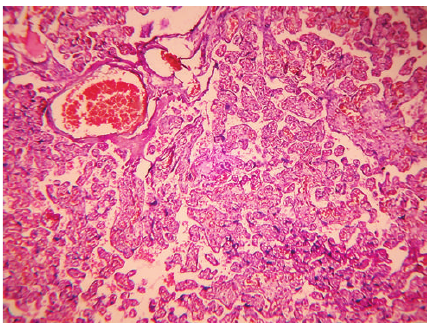
Figure 2: Terminal villi with focal chorangiosis in a placenta from a diabetic woman: H&E;